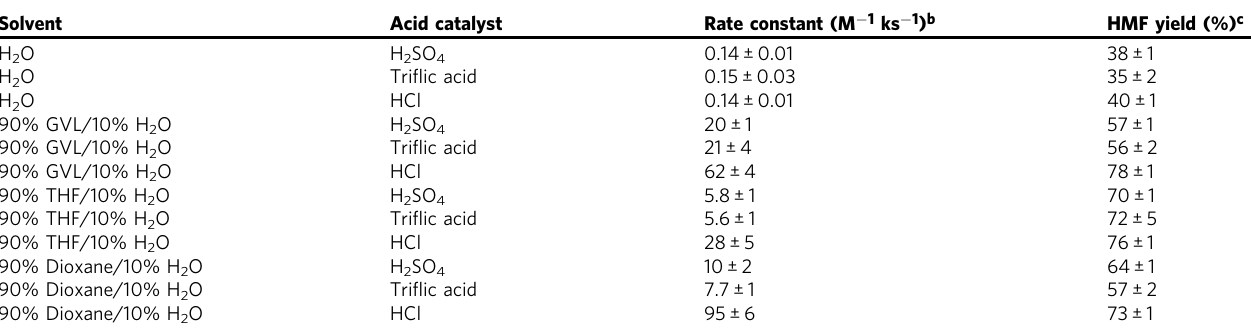
Table 1 Fructose conversion experimental results using homogeneous acid catalysts a Solvent